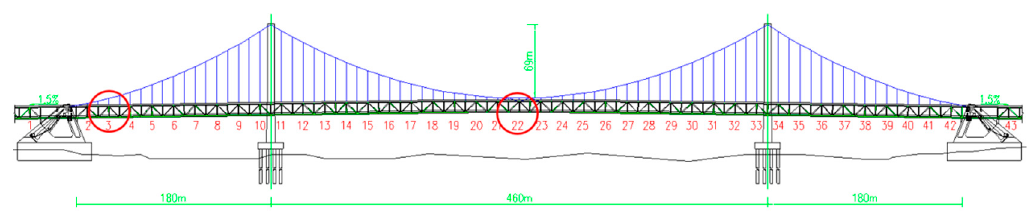
Figure 1. Elevation of the cross-sea bridge investigated in this study.